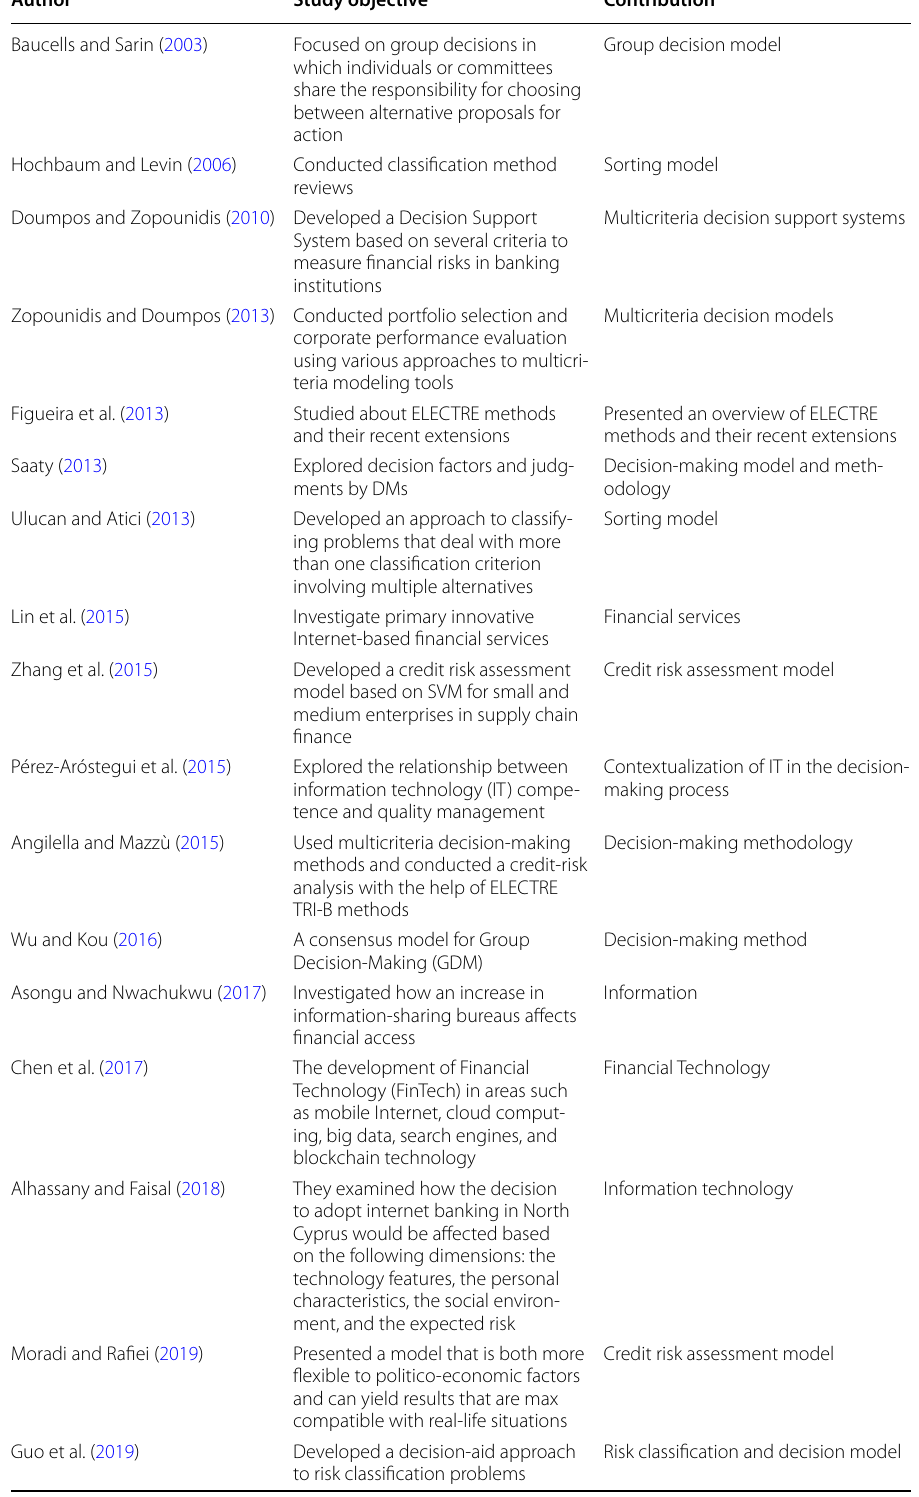
Table 3 Synthesis of models studied to understand the decision-making process